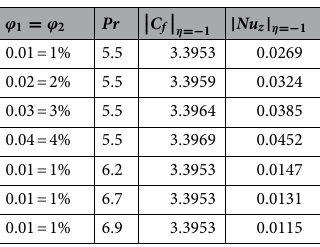
Table 5. Variation in C f and Nu z against ( Pr ) and volume fraction ϕ 1 , ϕ 2 for (Cu– TiO 2 / water) hybrid nanofluid when α = − 1, R = − 1, M = 1.